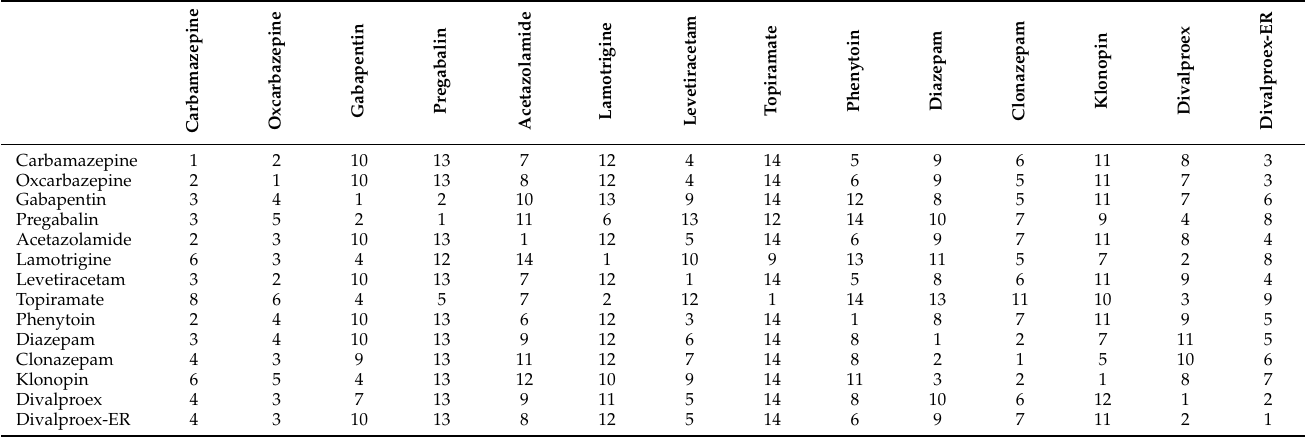
Table 7. AEDs Drug-Drug Similarity-based Rankings using ED